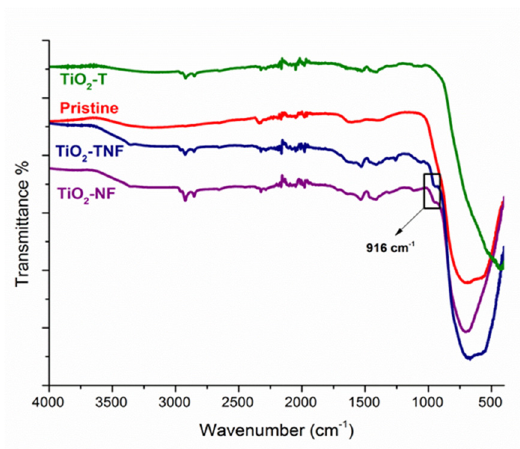
pristine, TiO -T, TiO -NF and 2 2 2